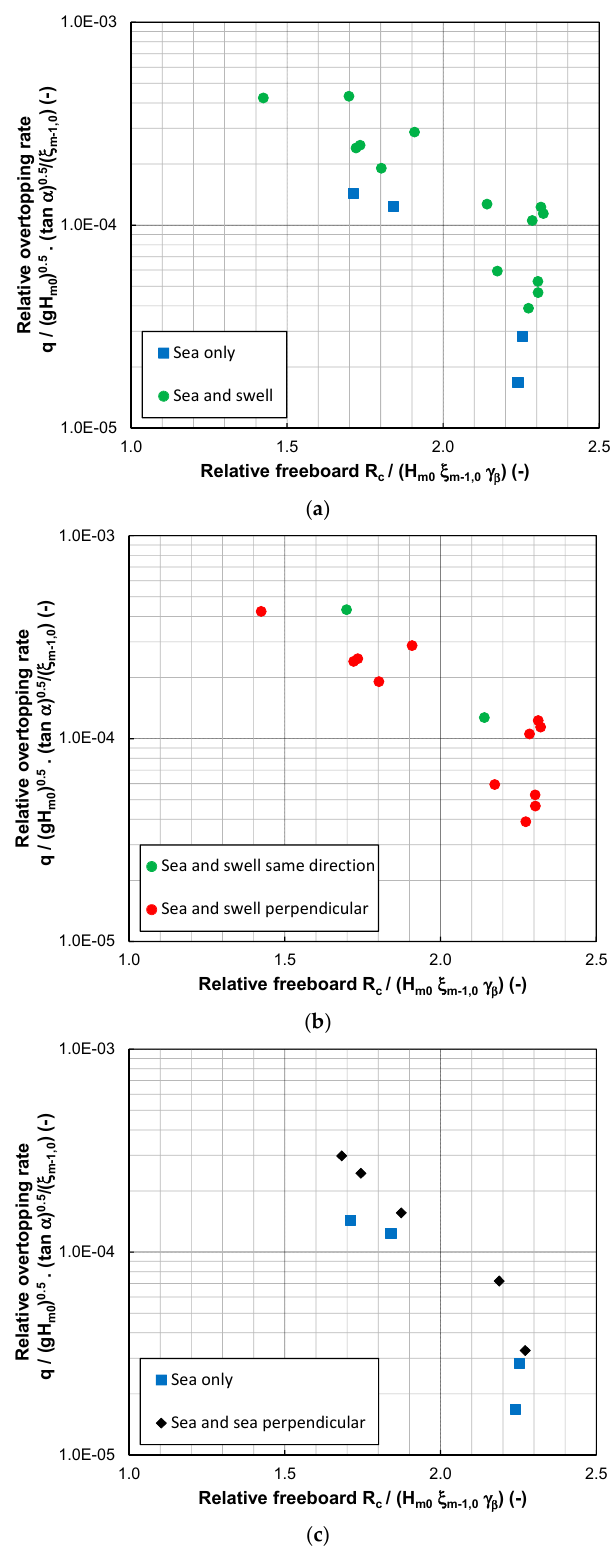
Figure 5. Comparison of overtopping discharges between various types of wave loading; ( a ) “sea” conditions versus “sea + swell” conditions; ( b ) “sea + swell” where they approach the structure in the same direction and “sea + swell” conditions where the “sea” and “swell” are perpendicular to each other; ( c ) “sea” conditions versus “sea + sea” conditions.